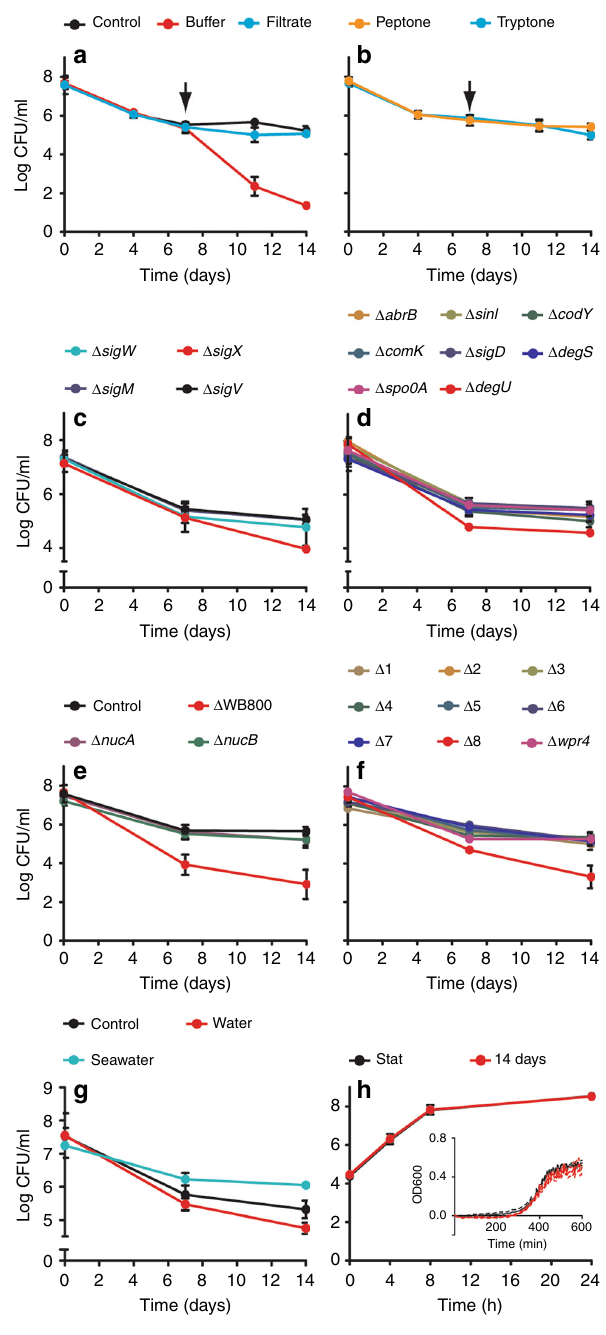
Fig. 8 Nutrient and genetic factors, and escape. a Importance of nutrients released by lysed cells was determined by fi ltering B. subtilis Δ spoIIE cultures (strain DG001) after 7-day starvation followed by